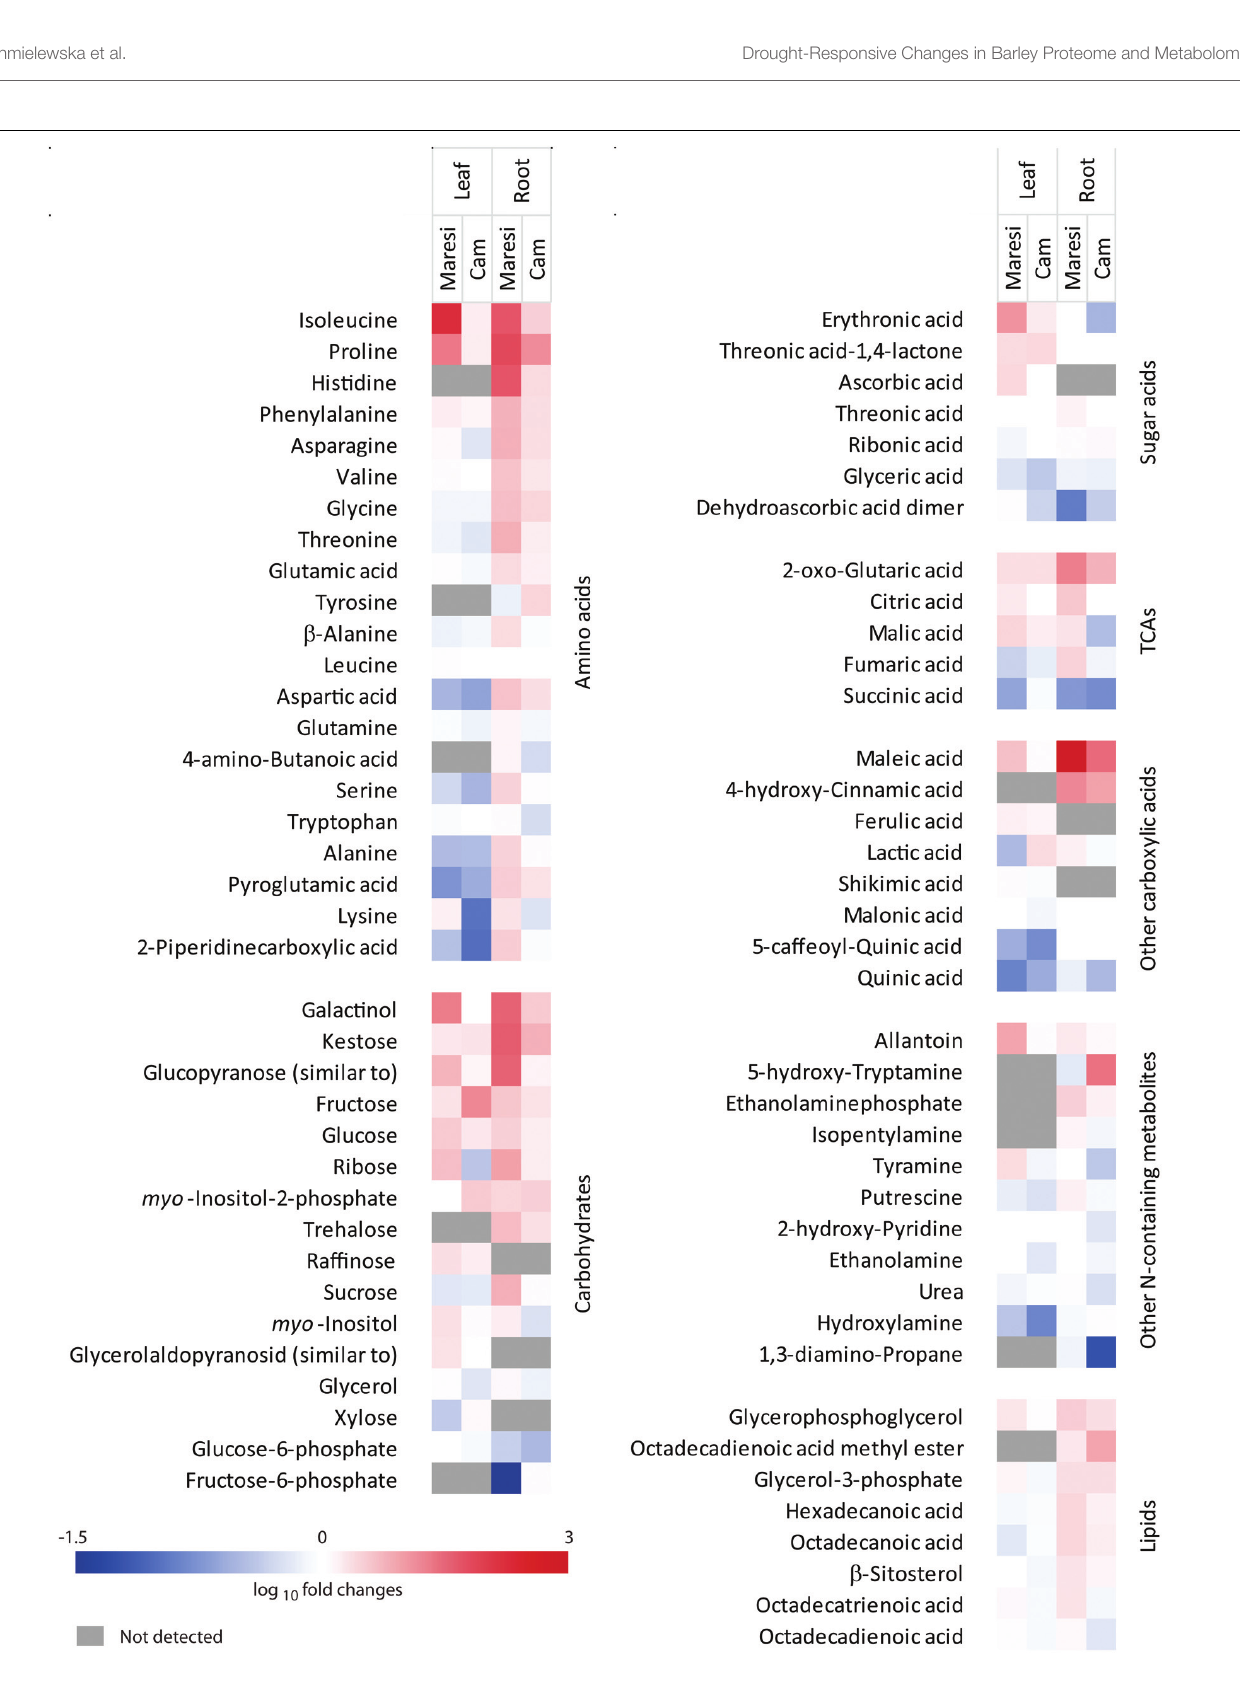
Frontiers in Plant Science |